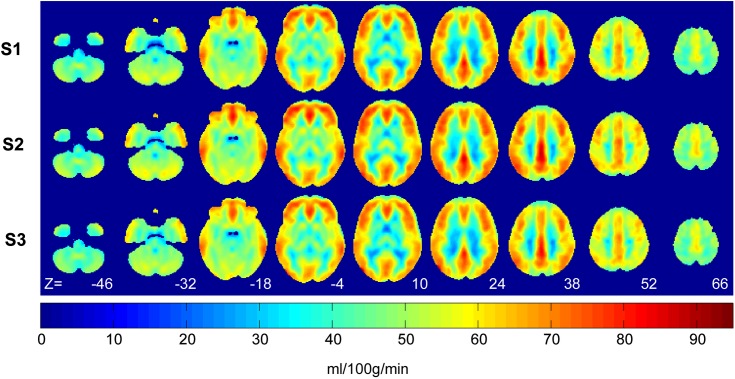
MNI-normalized images of group-averaged (N = 7) whole brain resting cerebral blood flow (ml/100g/min).Each session displayed, session 1(S1), session 2 (S2), and session 3 (S3), was the average of runs 1 and 2. Axial slice numbers (Z) in MNI co-ordinates are displayed at the bottom.